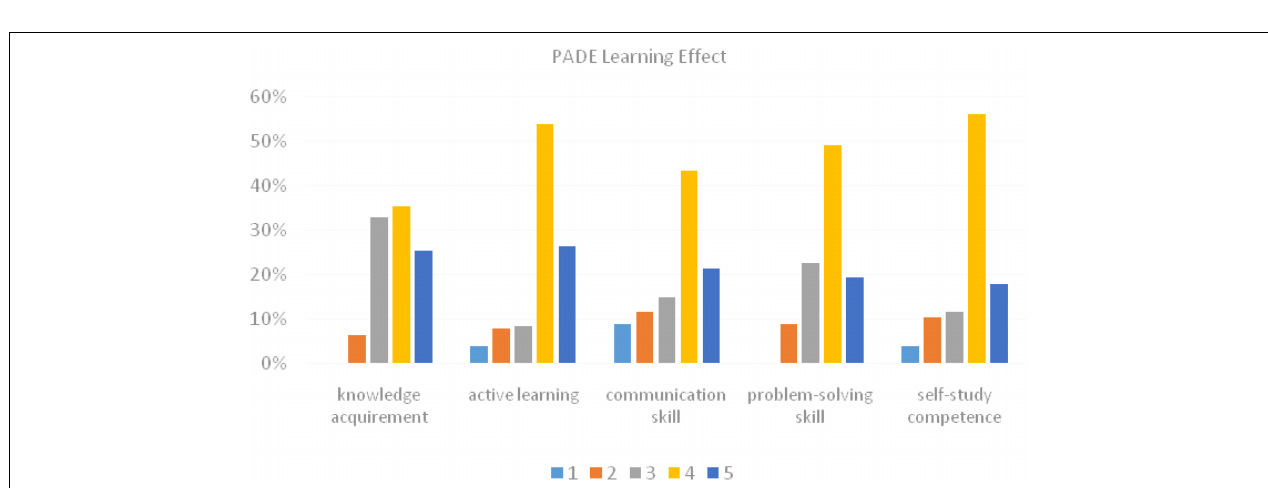
FIGURE 3 | Percentage of the PADE teaching effect: 1 – strongly disagree; 2 – disagree; 3 – neutral; 4 – agree; 5 – strongly agree.